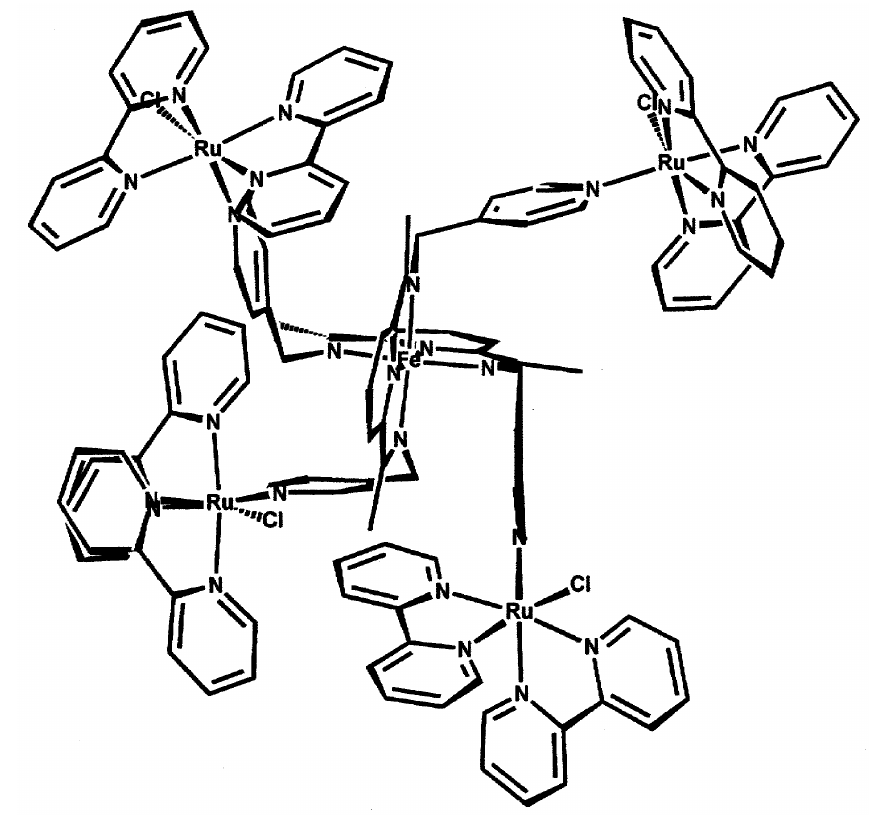
Fig. 4 – Structural representation of the [Fe(polyimine){Ru(bipy) 2 Cl} 4 ] 6 + complex.